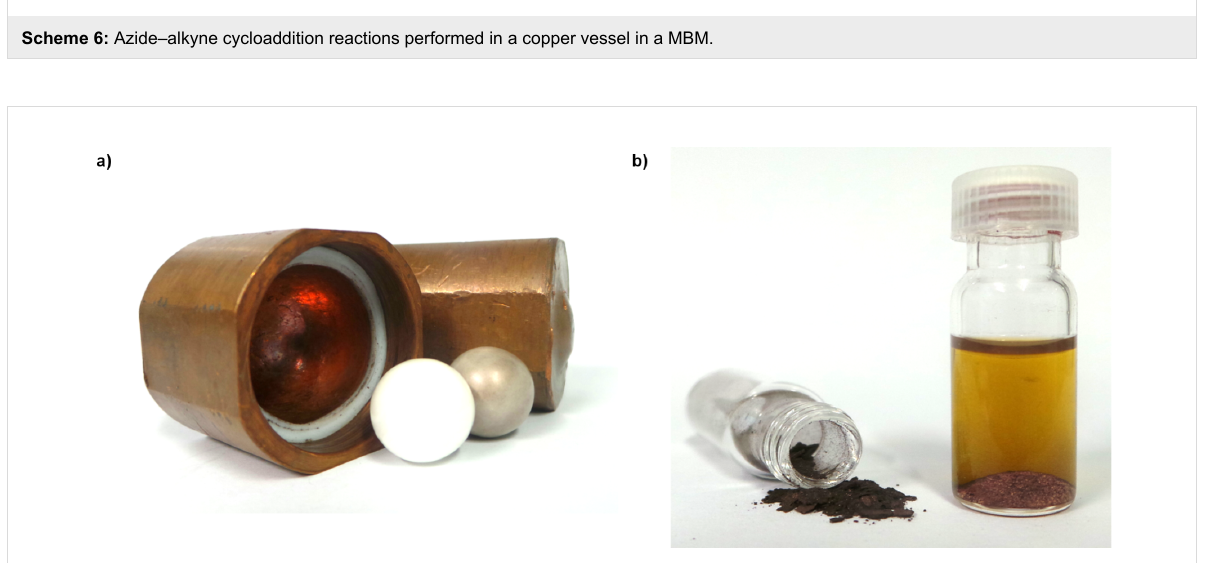
Figure 3: a) Custom-machined copper vessel and zirconia balls used to perform CuAAC reactions (showing: upper half of vessel with PTFE insert (front), pristine ZrO 2 ball, used ZrO 2 ball and lower half of vessel showing deformation of the metal). b) Crude solid ball mill click reaction mixture after removal from copper vessel (left) and during extraction of pure product with DMSO (right).